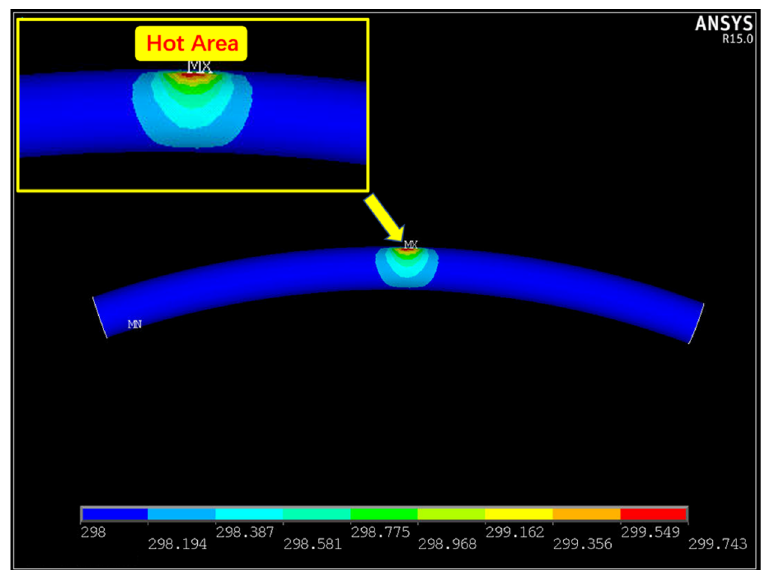
Figure 8. Simulation of temperature distribution along the bending areas of